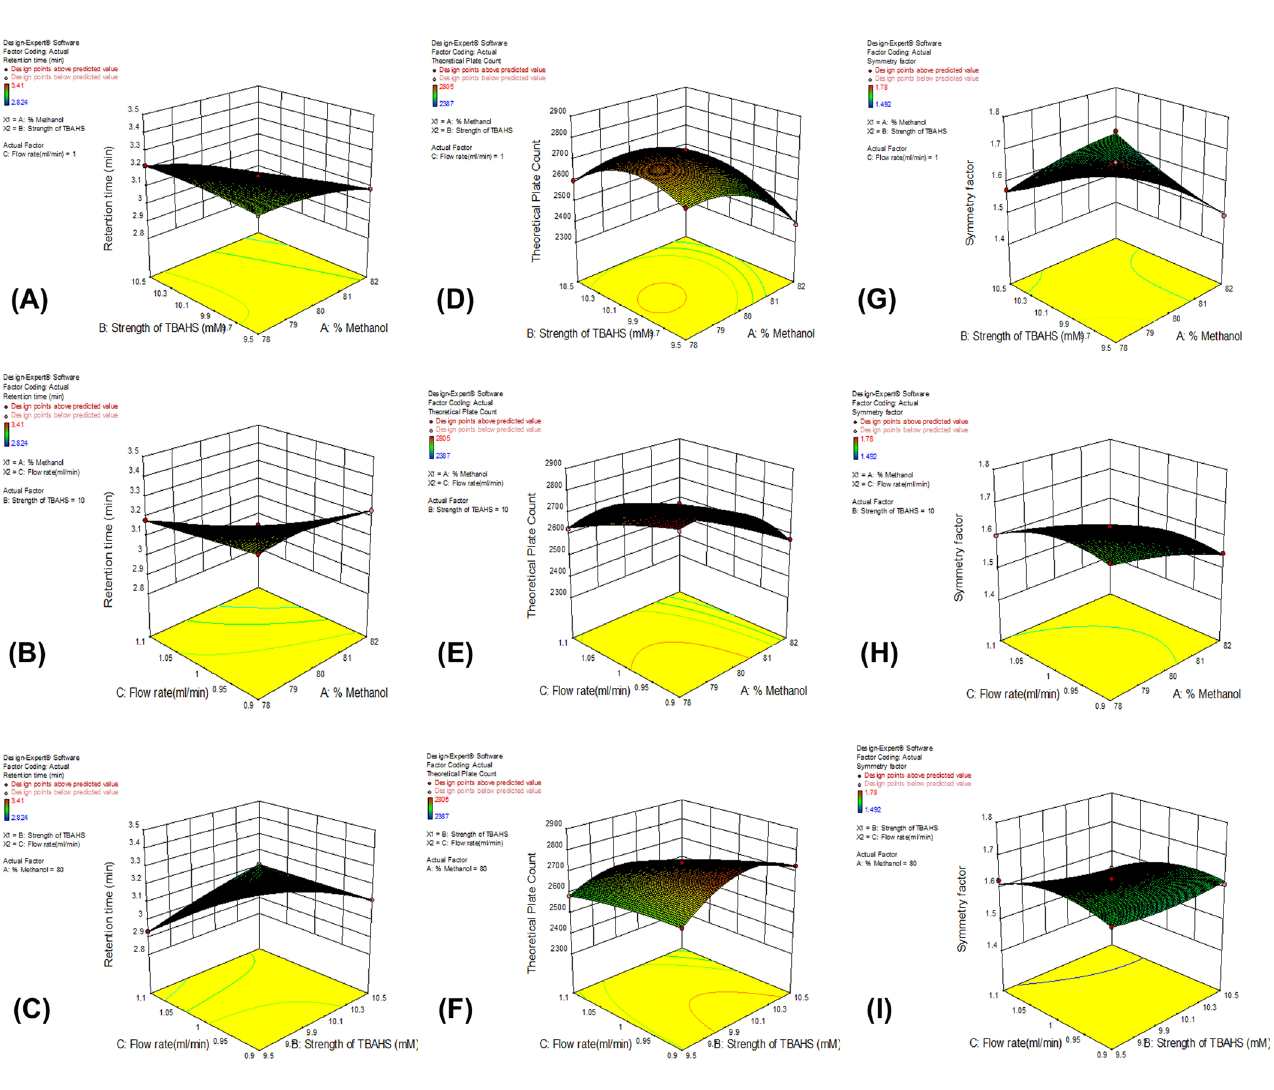
FIGURE 3 - Three dimensional response surfaces obtained for CQAs viz. (A-C) retention time, (D-F) theoretical plate count and (G-I) symmetry factor using experimental design